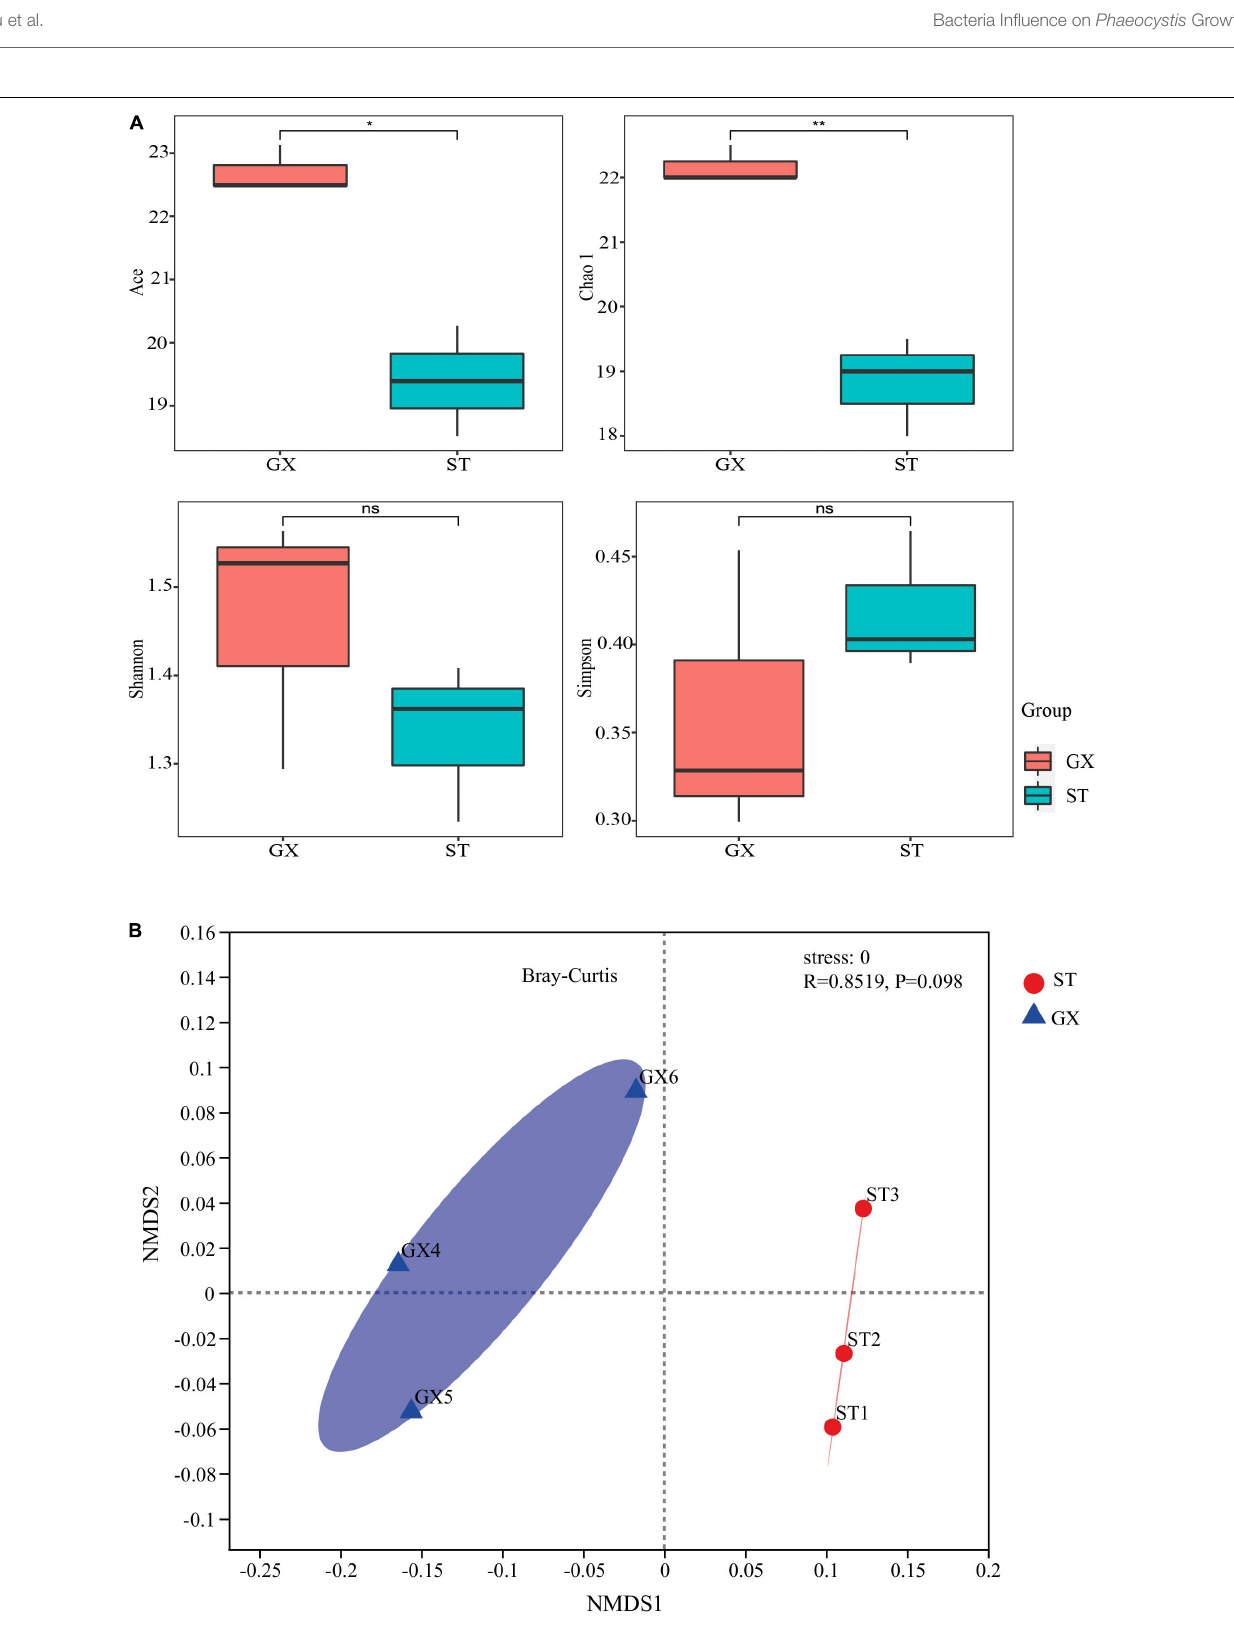
Frontiers in Microbiology |